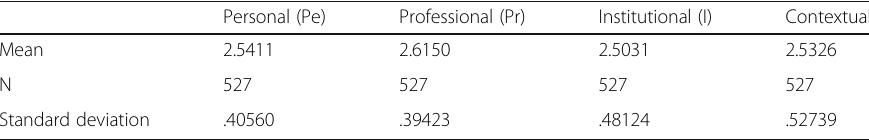
Table 2 Mean ranking for barriers to DT integration according to dimension Personal (Pe) Professional (Pr) Institutional (I) Contextual (C) Mean 2.5411 2.6150 N 527 527 Standard deviation .40560